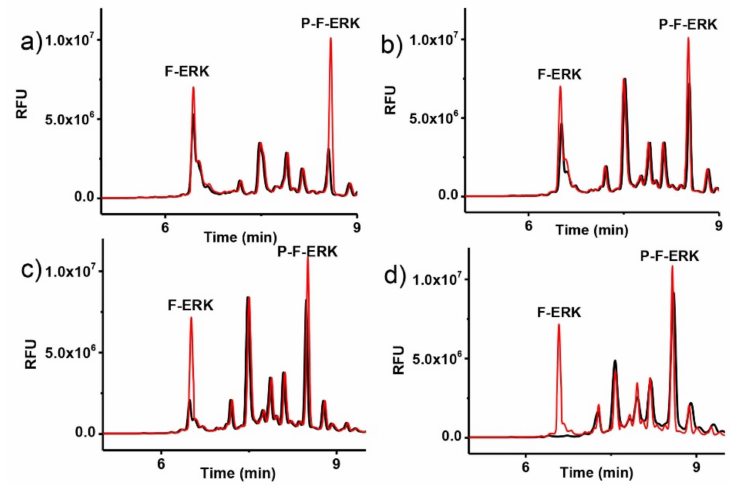
Figure 4. Time course study of enzymatic reaction. Extracted media from gastric cancer MKN-1 cells treated with 2 µ g / mL F-ERK, 0.01 µ g / mL PKC δ , 50 mM Adenosine triphosphate ATP, and incubated at di ff erent time intervals. ( a ) 3 h incubation; ( b ) 6 h incubation; ( c ) 12 h incubation; ( d ) 24 h incubation. Reproduced with the permission of